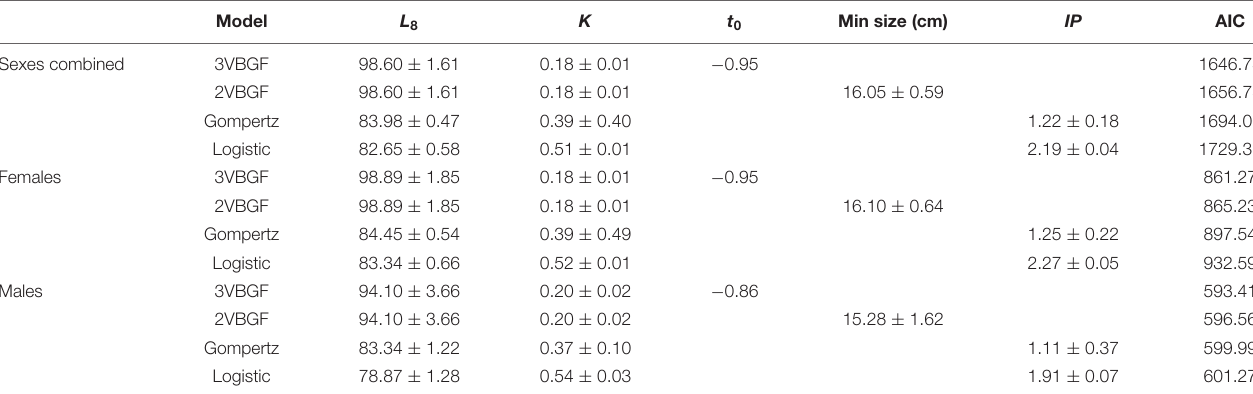
TABLE 2 | Growth parameters (mean ± standard error) calculated for the four tested models for females, males, and the sexes